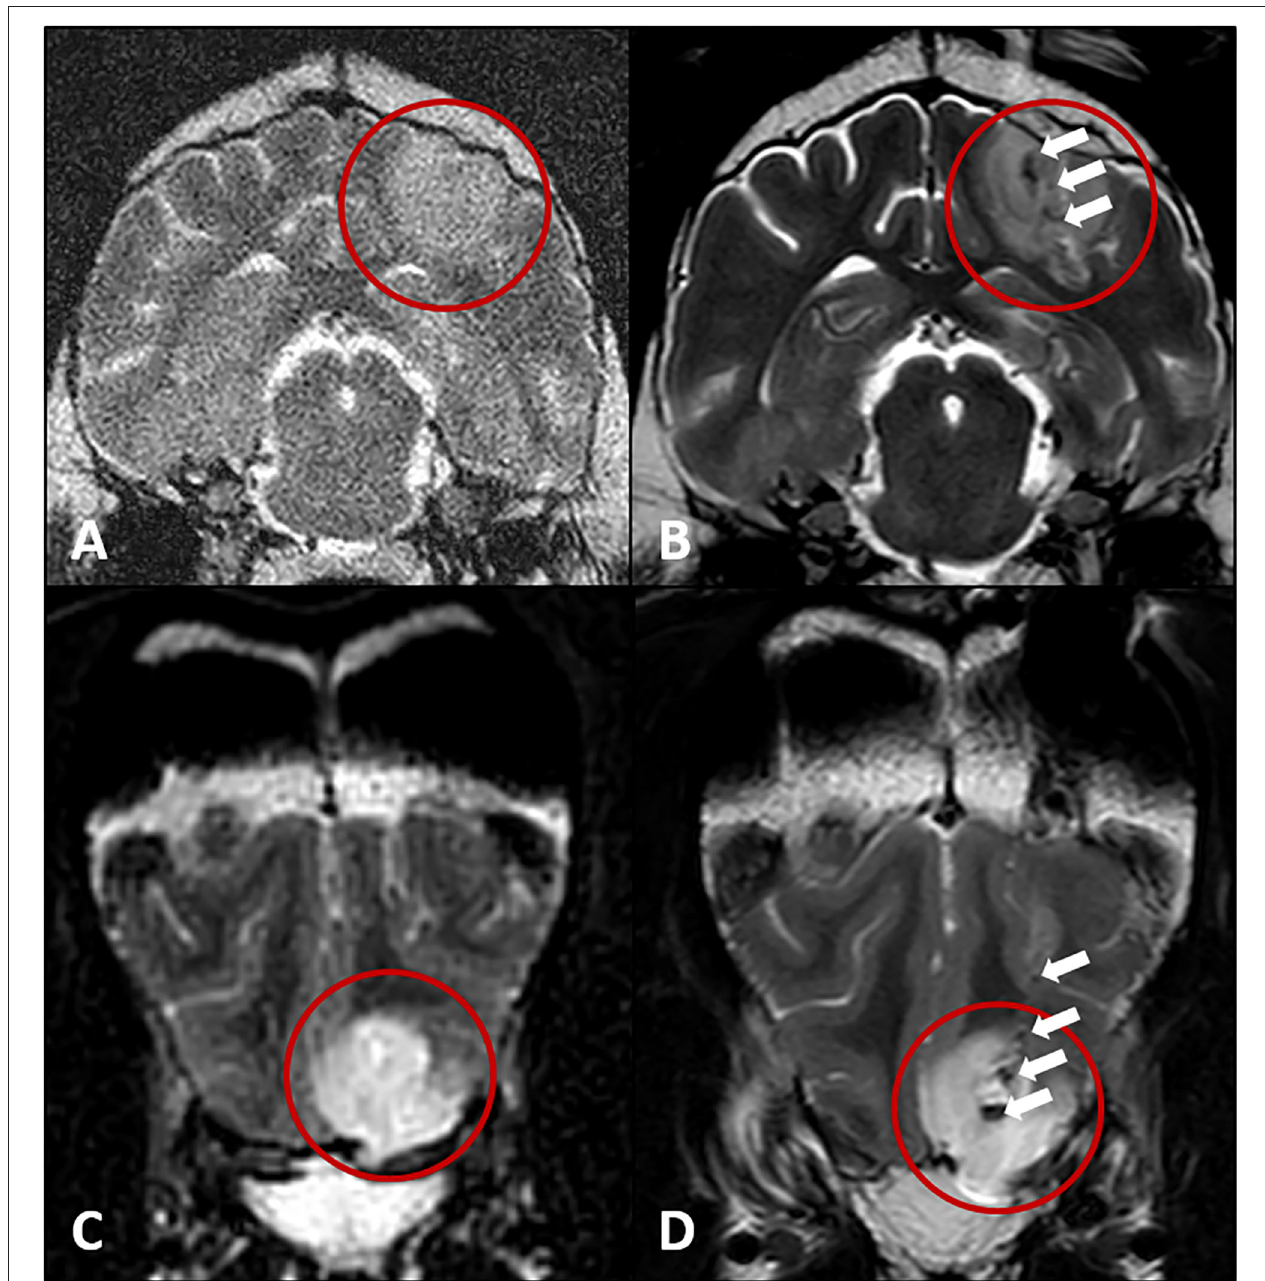
FIGURE 3 | Transverse T2W MRI images of the hyperintense intracranial lesions (red circles) of the dogs in cases 1 and 2 before (A,C) and after the brain biopsy procedure (B,D) . T2W hypointense artifacts along the biopsy trajectories (white arrows, presumptive air) leading into the brain lesion of cases 1 (B) and 2 (D) .